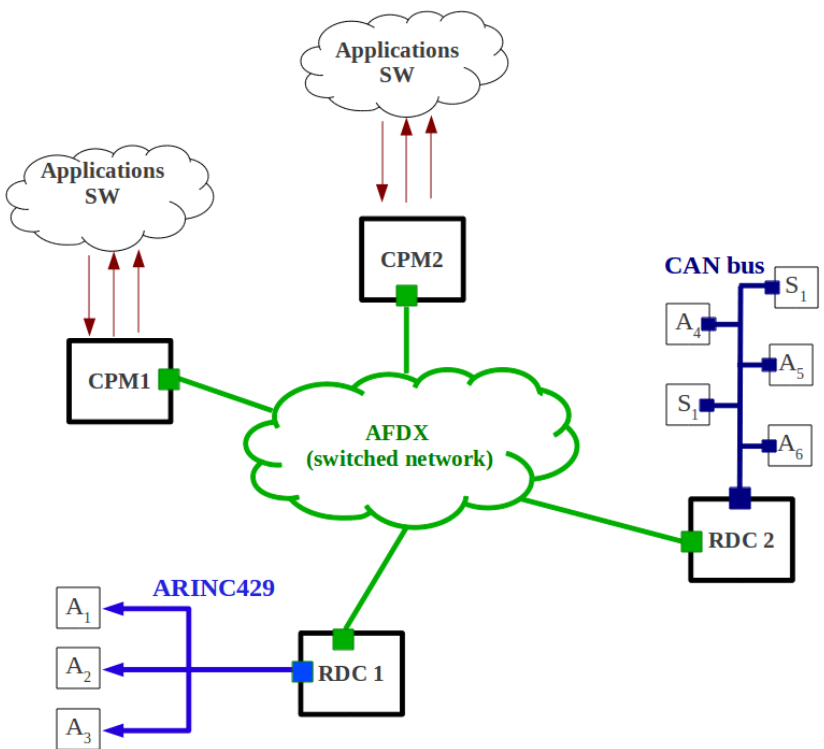
Figure 1. An Example of the Aircraft Data Communication Network